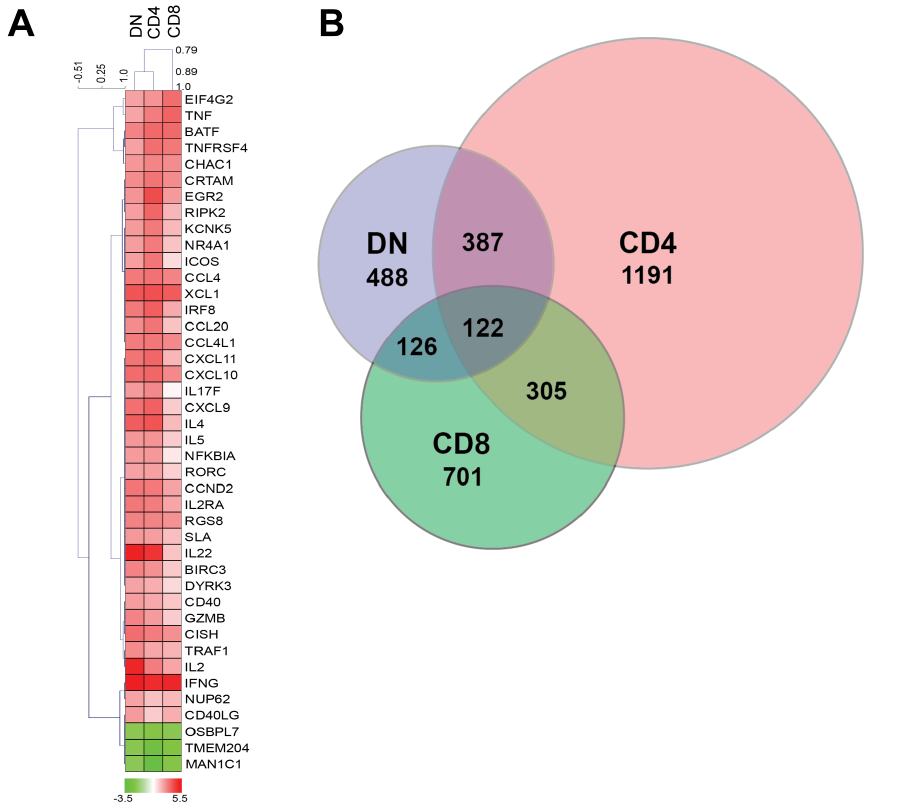
Figure 2. Transcriptome analysis utilizing microarray of stimulated CD4, CD8 and DN T cells from uninfected mangabeys demonstrates relatedness of CD4 and DN T cells. A) Heat map and hierarchical cluster analysis of genes that were differentially regulated over 4 fold are depicted for DN (lane 1), CD4 (lane 2) and CD8 T cells (lane 3). Red indicates upregulation and green indicates down regulation for each gene listed on the right. B) Venn Diagram representing overlap of differentially regulated genes (2 fold) identified from the microarray analysis of CD4, CD8 and DN T cells stimulated through their TCR (anti CD3/CD28). and CD4 + T cells (Figure 4, black symbols compared to open symbols). The one difference observed was that IL4 upregulation was higher in the DN compared to the CD4 T cells, indicating that DN T cells were particularly adept at making this cytokine (Figure 4). Following a more robust stimulation with the mitogen PMA/Ionomycin, a significant elevation in cytokine mRNA levels (compared to TCR stimulation) was observed in both DN and CD4 T cells however no significant difference in was observed between CD4 and DN T cells (Figure S5). IFN a and TGF b mRNA were detectable, but their levels were not upregulated in DN or CD4 T cells following either TCR or mitogen stimulation. Importantly, we observed that DN T cell function was similar in both SIV + CD4-low mangabeys (Figure 6, red symbols) and SIV + CD4-healthy mangabeys (black filled symbols) following either TCR or PMA/Ionomycin stimulation (Figures 6 and S5). There was no significant difference between cytokine mRNA expression of DN T cells between CD4-low and CD4-healthy mangabeys in these signature T helper cytokines indicating a maintained function despite CD4 loss.